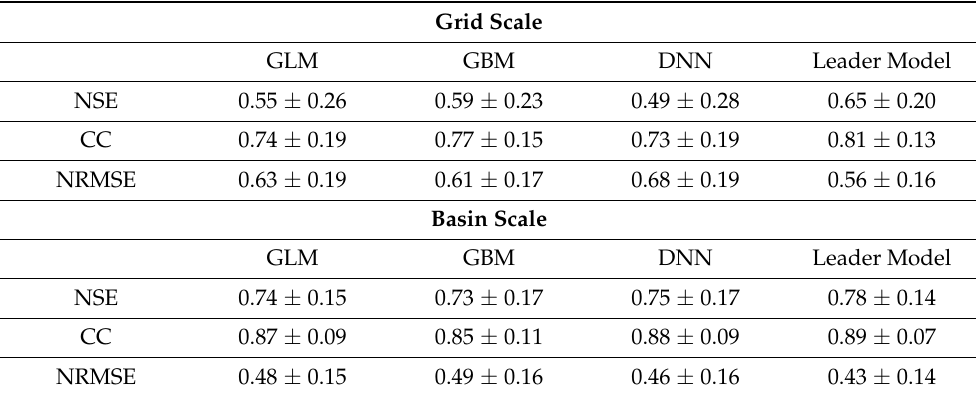
Table 2. The average testing performance matrices for grid and basin